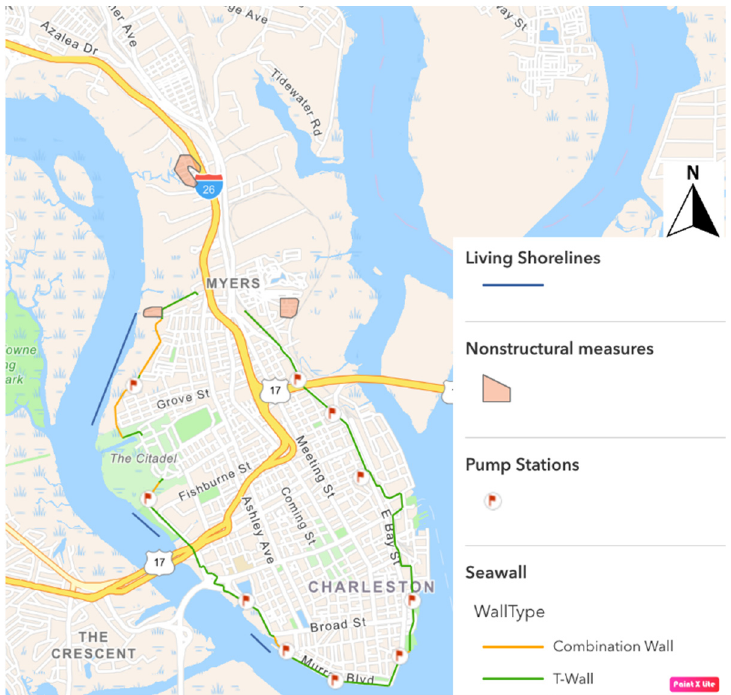
Figure 4. Map of proposed surge wall location on the Charleston, SC peninsula, digitized from the USACE NEPA (National Environmental Policy Act) Scoping Meeting Presentation [15]. Green lines represent T-Wall locations, orange lines represent combination wall locations, pink polygons represent nonstructural measures such as floodproofing or elevating homes, red flags represent locations of pumping stations, and blue lines represent locations of living shorelines.